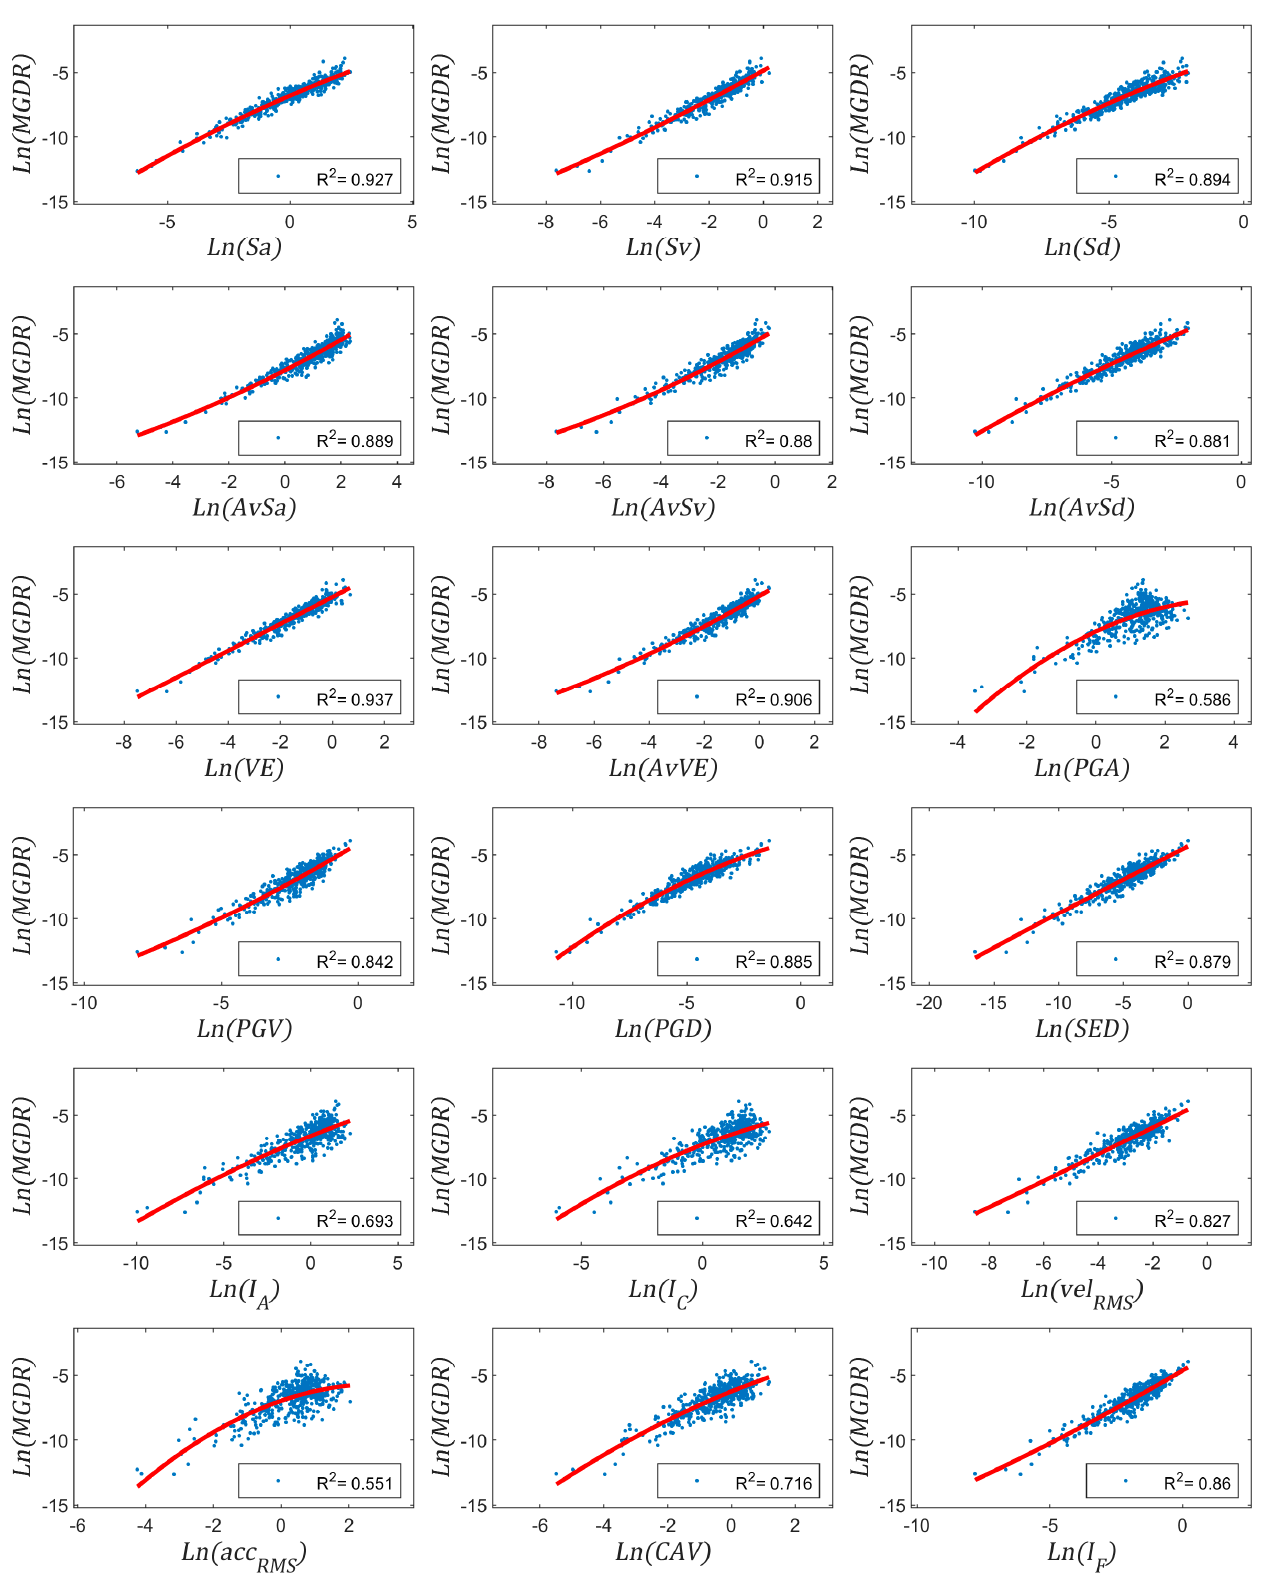
Figure 5. Correlation coefficient between IMs and MGDR in the log-log space for near-fault records.